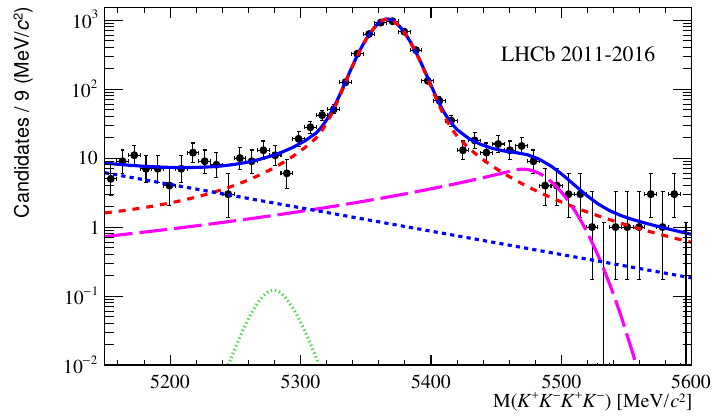
Figure 6 . Fit to the four-kaon invariant mass. The total PDF as described in the text is shown as a blue solid line, B 0 ! (cid:30)(cid:30) as a red dashed line, B 0 ! (cid:30)(cid:30) as a green dotted line, the (cid:3) 0 s contribution as a magenta long-dashed line and the combinatorial background as a blue short- dashed line.